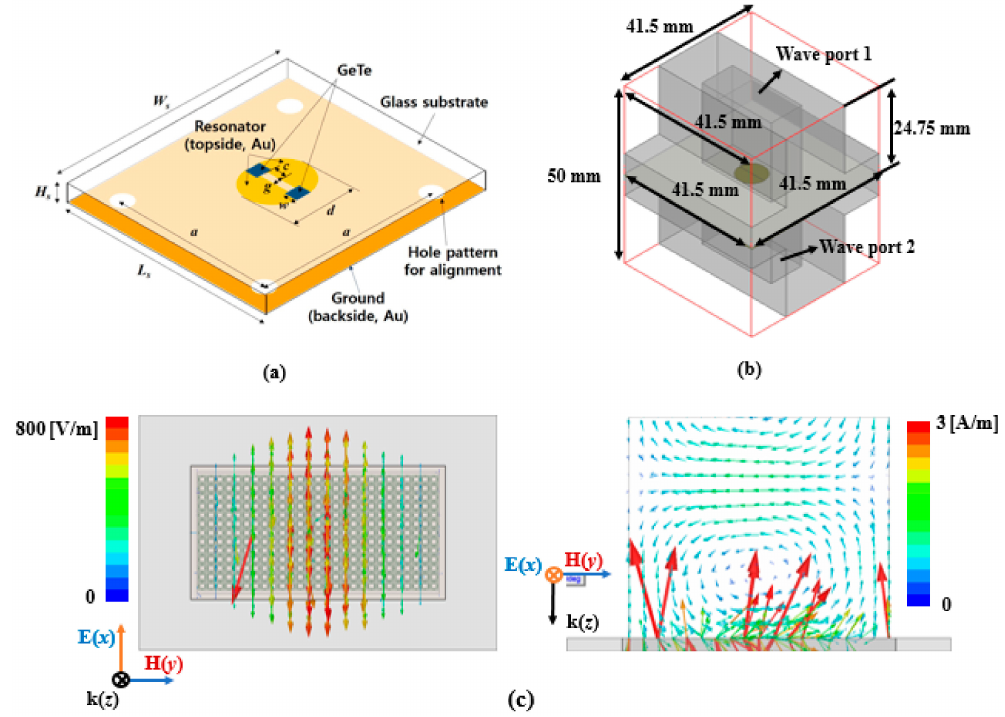
Figure 1. ( a ) Three-dimensional unit cell geometry of the proposed frequency reconfigurable electromagnetic absorber, ( b ) waveguide setup for the numerical simulation and ( c ) simulated E, H- field vectors on XY and YZ planes in the rectangular waveguide at 10.4